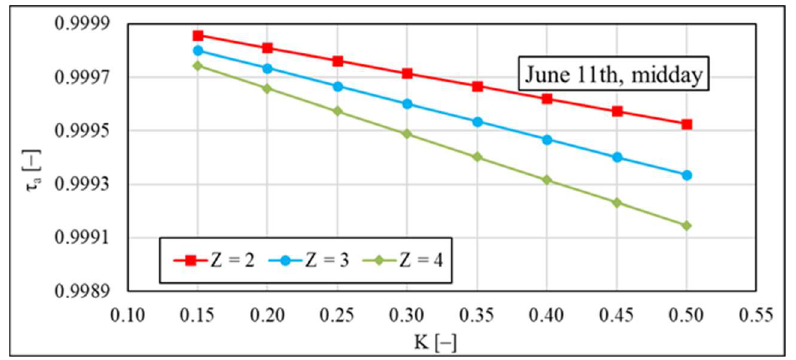
Figure 8. Transmissivity after accounting for absorption of solar radiation by polycarbonate as a function of extinction coefficient—11th of June, noon.